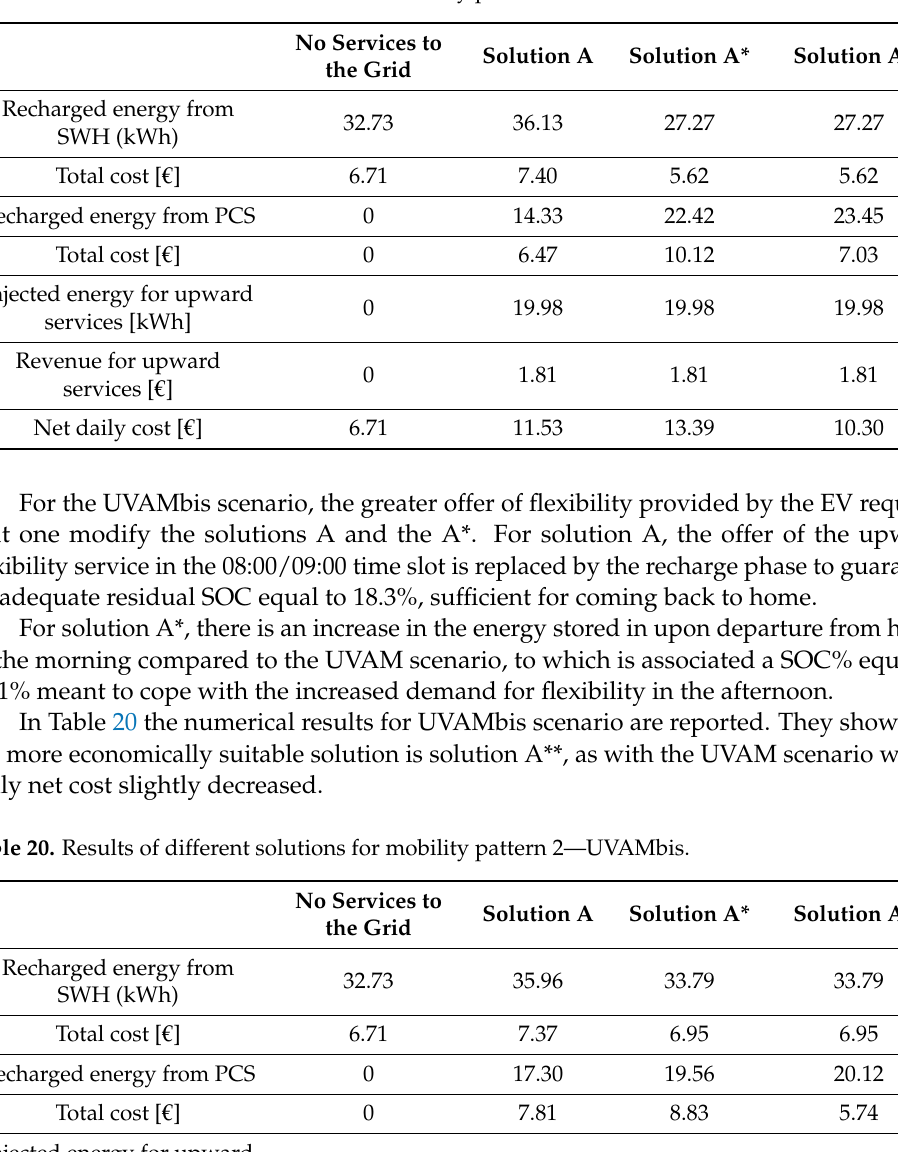
Table 19. Results of different solutions for mobility pattern 2—UVAM.